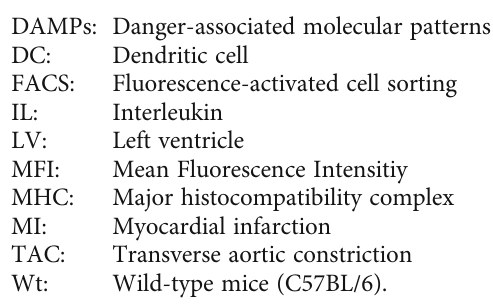
Supplemental Figure 1: fl uorescence minus one (FMO) con- trols of CD11c and CD103 staining in addition to Figure 1. Supplemental Figure 2: direct comparison of CD86 MFI of CD11c + cells in heart, aorta ascendens, aorta descendens, and lymph node in addition to Figure 5. (Supplementary